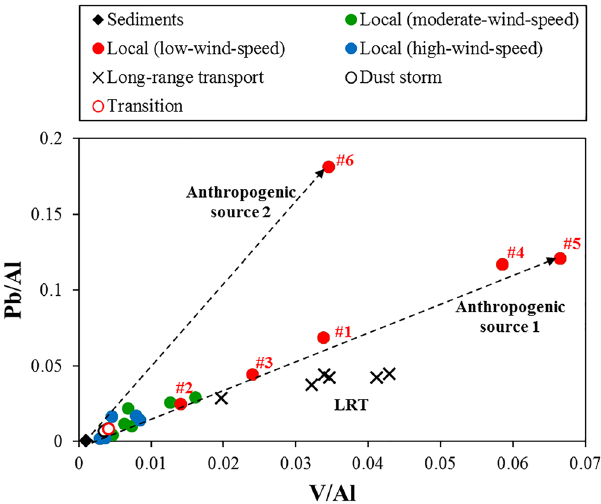
Figure 3. Plot of Pb/Al versus V/Al for PM 10 and sediments collected in central Taiwan.